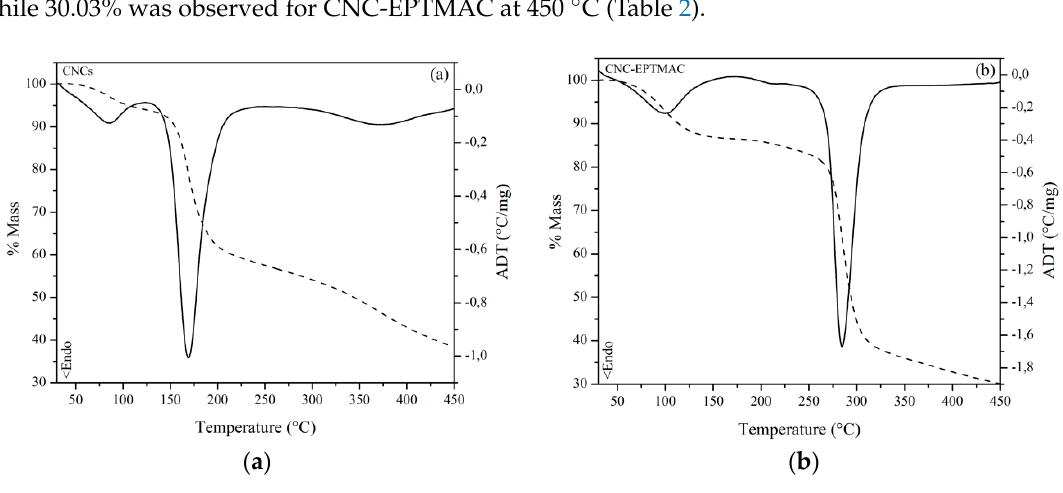
Figure 5. Thermogravimetric analysis (dotted line) and differential thermal analysis (unbroken line) of: ( a ) CNC and ( b ) CNC-EPTMAC.